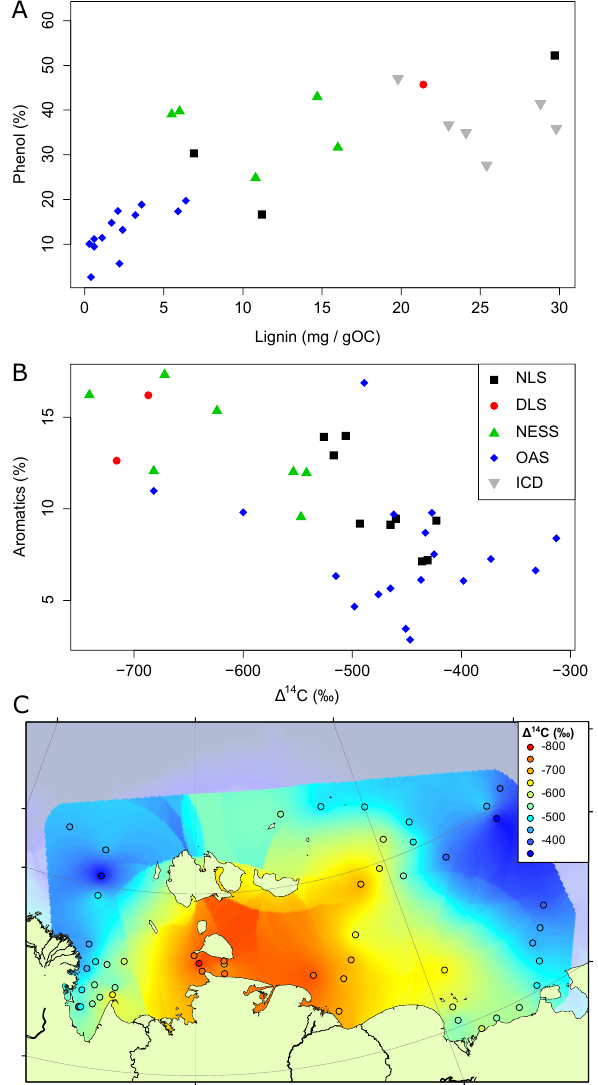
Figure 4. Correlation plots of (a) relative abundance of phenols vs. measured concentration of lignin phenols in identical samples as measured by Tesi et al. (2014) and (b) relative abundance of aro- matics vs. (cid:49) 14 C OC measurements from this study and Vonk et al. (2012). In each case, samples are distinguished by sample area (see legend; sample areas defined in Fig. 1). (c) Map of radiocarbon ( (cid:49) 14 C OC ) values measured in this study and Vonk et al. (2012). Interpolation of (cid:49) 14 C OC data was performed using a kriging algo- rithm within the software package ArcGIS. (DLS: Dmitry Laptev Strait; NLS: nearshore Laptev Sea; NESS: nearshore East Siberian Sea; OAS: offshore Arctic